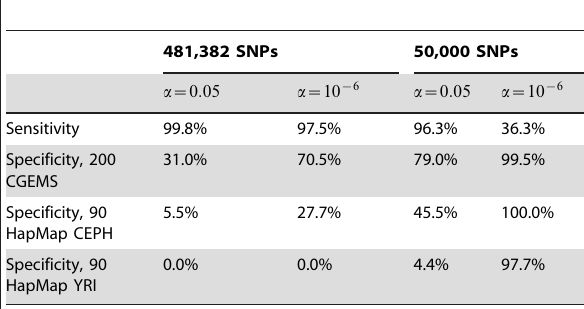
Table 2. Empirical sensitivity and specificity for the tests